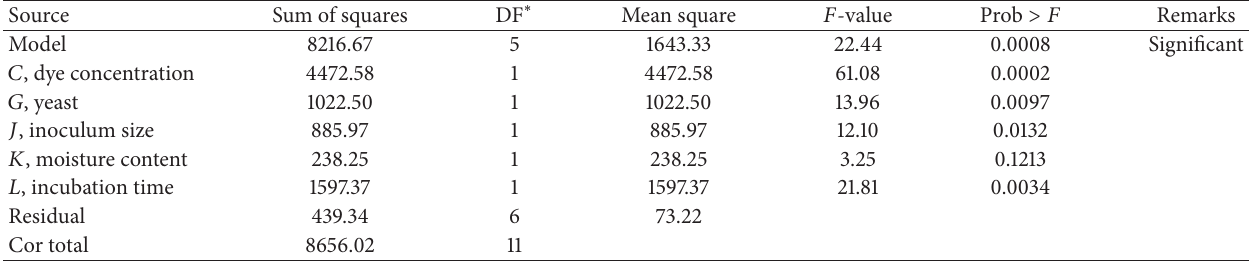
Table 6: Analysis of variance for the regression model and respective model terms.